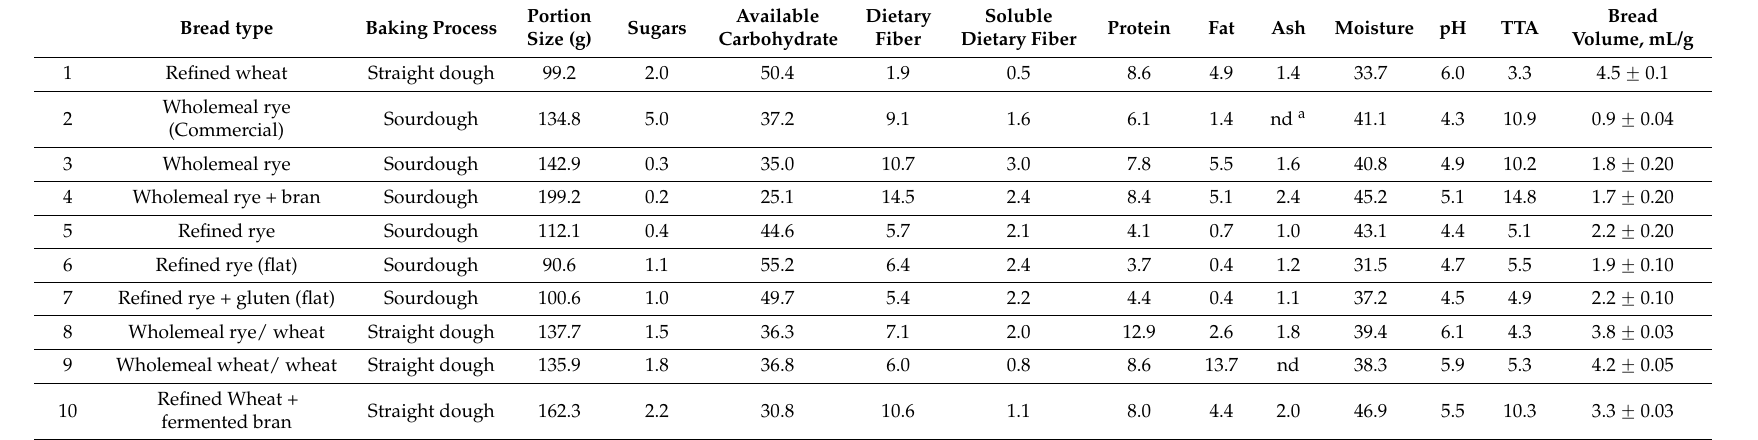
Table 1. Characteristics of rye and wheat breads (chemical composition expressed g/100 g fresh weight). Standard deviation in chemical composition data was less than